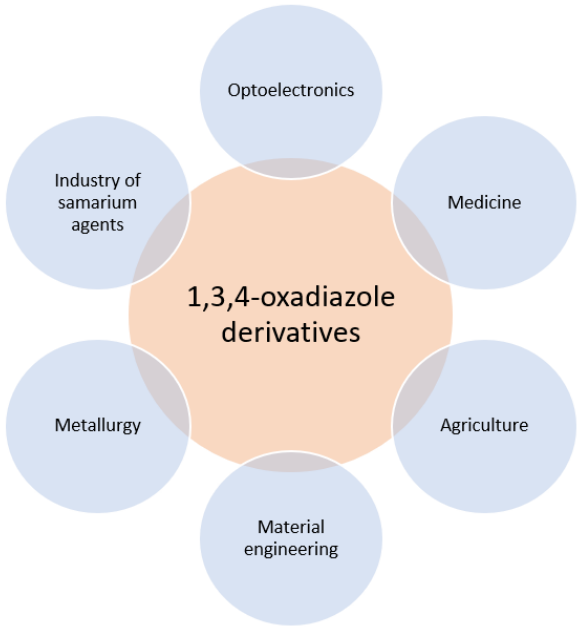
Figure 1. Possible applications of 1,3,4-oxadiazole